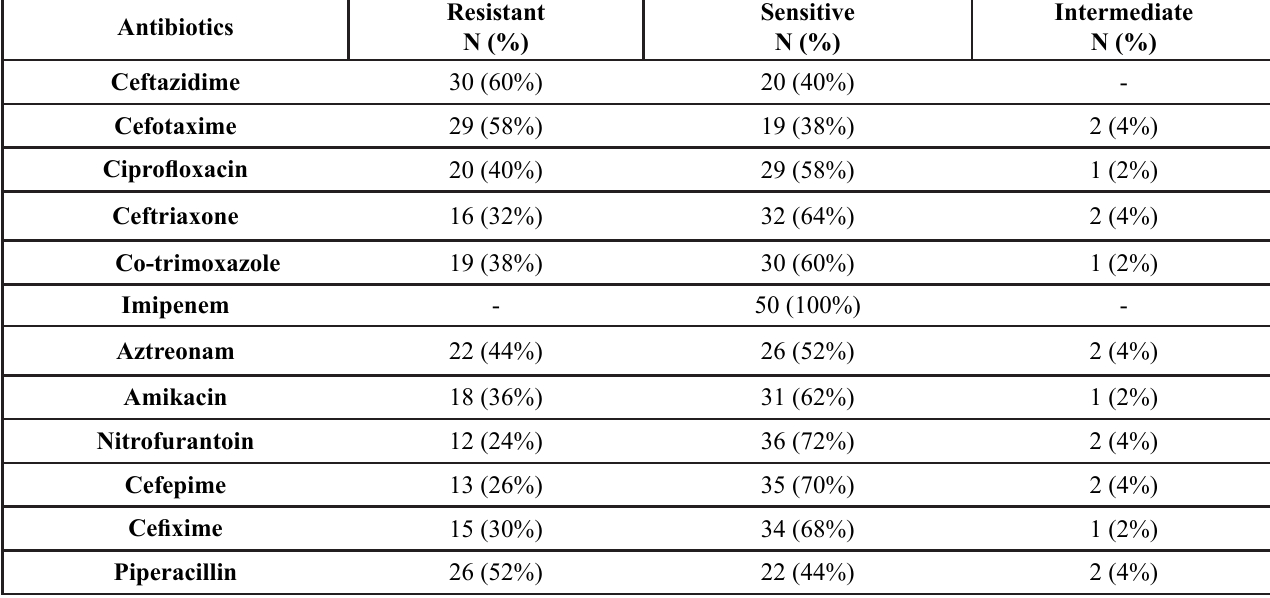
Table 2. The frequency of susceptibility and resistant antibiotics among isolated K. pneumoniae strains Resistant Antibiotics